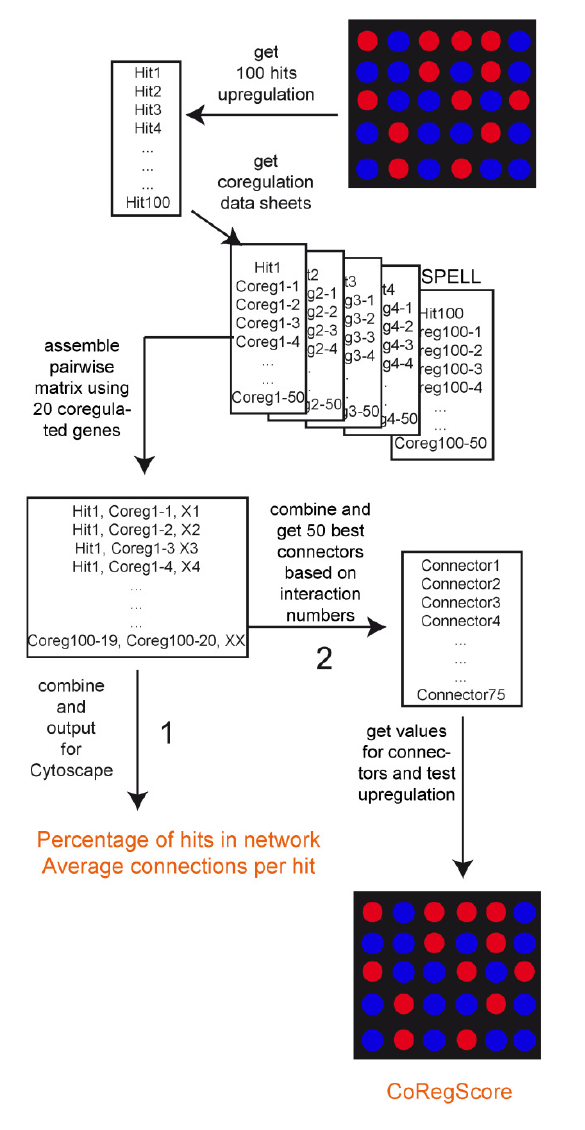
FIGURE 1: Data processing in ClusterEx. A flexible number of hits (here the top 100) are obtained from the microarray data set as “hits”. For each hit, the best co-regulators (here 50) are obtained from the SPELL database. These are assembled into a pairwise matrix. After combining, each pair is only listed once with the number of occurrences (X). This matrix then is exported to Cyto- scape and values are reported for percentage of hits included in the network and connection numbers per hit (Pathway 1). Fur- thermore, a flexible number (here 50) of connectors from the matrix can be included into the network. For those the real ex- pression values are obtained from the experimental data set. The CoRegScore is calculated from the positioning of these predicted connectors in the hit list of the experiment (Pathway 2). This pro- cedure is described in the materials and methods